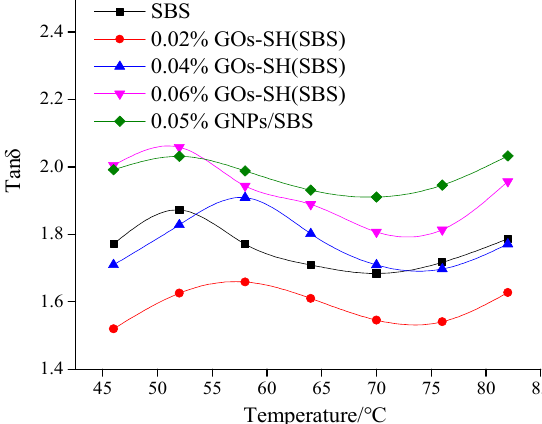
Figure 5. Effect of GOs-SH content on G ′ as a function of shear frequency at 64 °C.